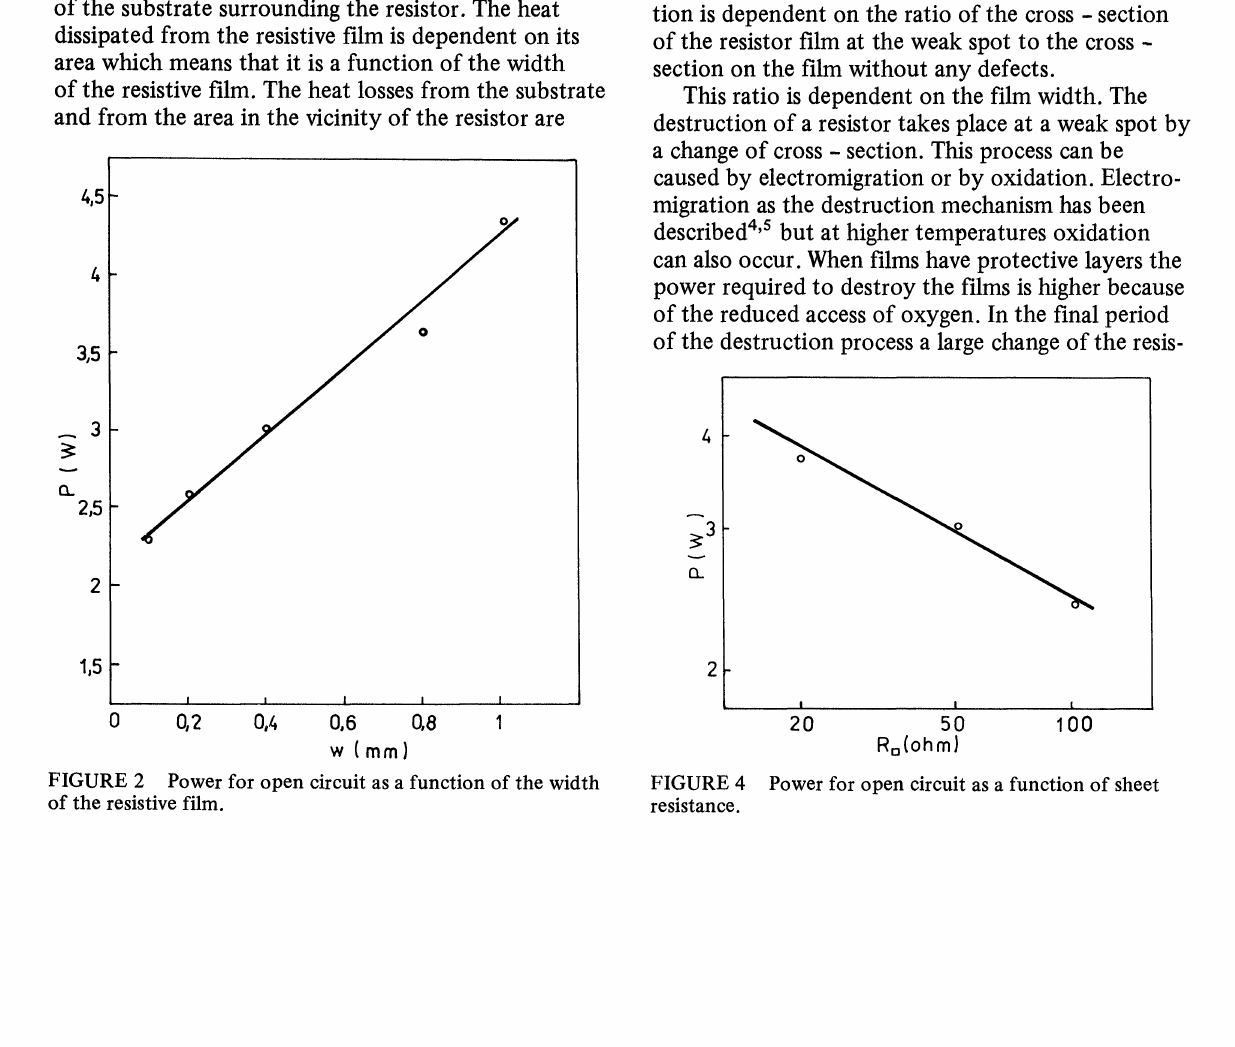
FIGURE 2 Power for open circuit as a function of the width of the resistive film.